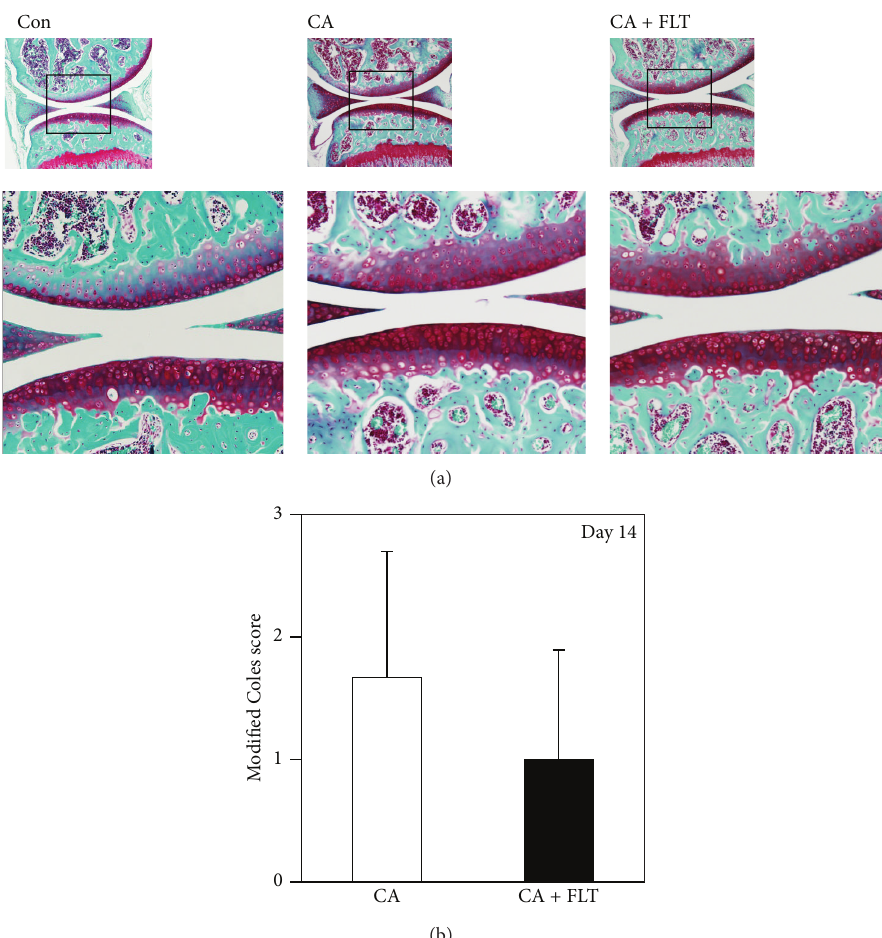
Figure4:Histologicalanalysesofarticularcartilagedegenerationinducedbycarrageenanatday14.(a)Safranin-Ostainingofsagittalsections of mice knee joints at day 14 after carrageenan injection. Boxed areas in the top panels are magnified and presented in the bottom panels. CA: carrageenan group; CA + FLT: carrageenan + follistatin group; Con: control group. Magnification: top × 40, bottom × 100. (b) Semiquantitative analyses of articular cartilage degeneration. The degree of articular cartilage degeneration was semiquantitatively evaluated ( Modified Coles Score ( Coles et al., Arthritis & Rheumatology, 2010 ) [19]). Histological scores of articular cartilage from femurs and tibiae were evaluated, respectively, and total scores were compared between the two groups ( ∗ 𝑃 < 0.05)